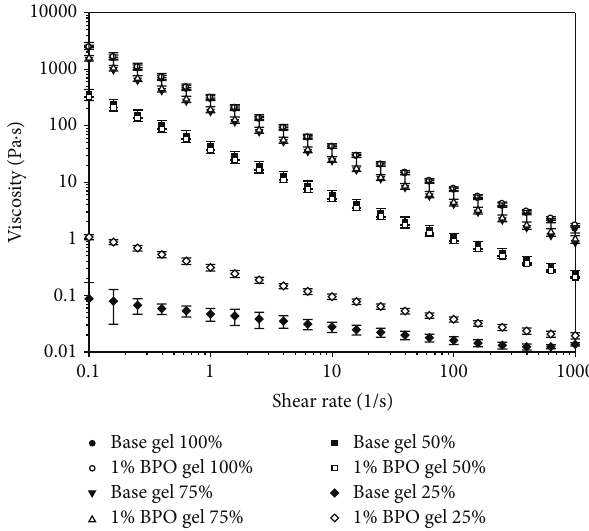
Figure 7: Viscosity (Pa ⋅ s) as a function of shear rate (1/s) of 100%, 75%, 50%, and 25% dilutions in VFS of base gel and 1% BPO gel. Experiment was conducted in triplicate. Mean values and standard deviations of three experiments are